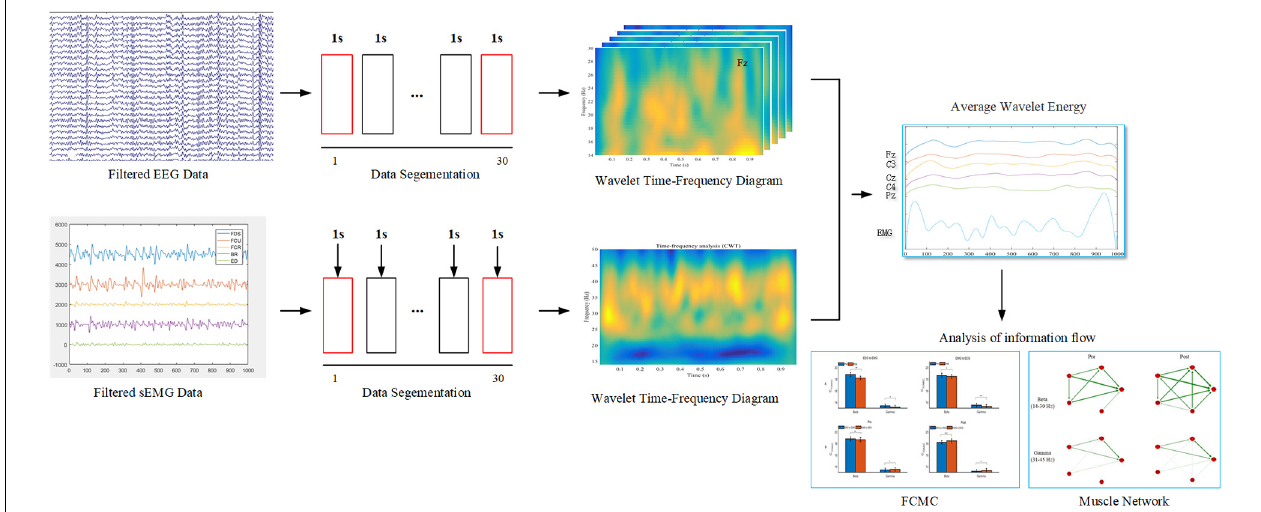
FIGURE 2 | The procedure for EEG and sEMG data analysis. In the data segmentation phase, the 2–29 s data were selected for subsequent analysis.